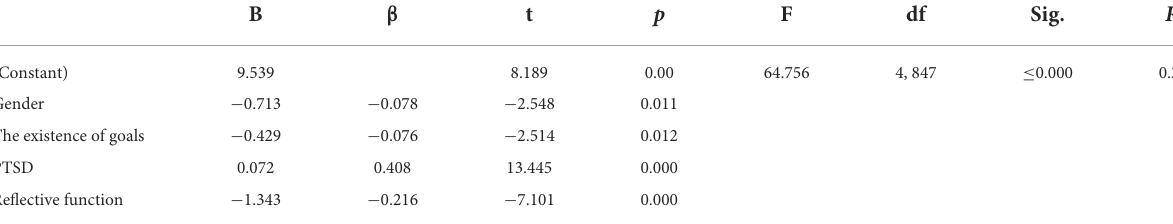
TABLE 13 Linear regression summary for disorganized